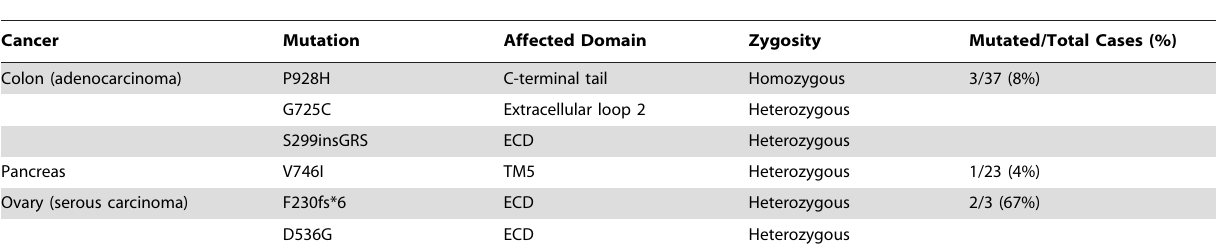
Table 1. Somatic cancer mutations of LGR6 listed in the COSMIC database as of Jan-2012.